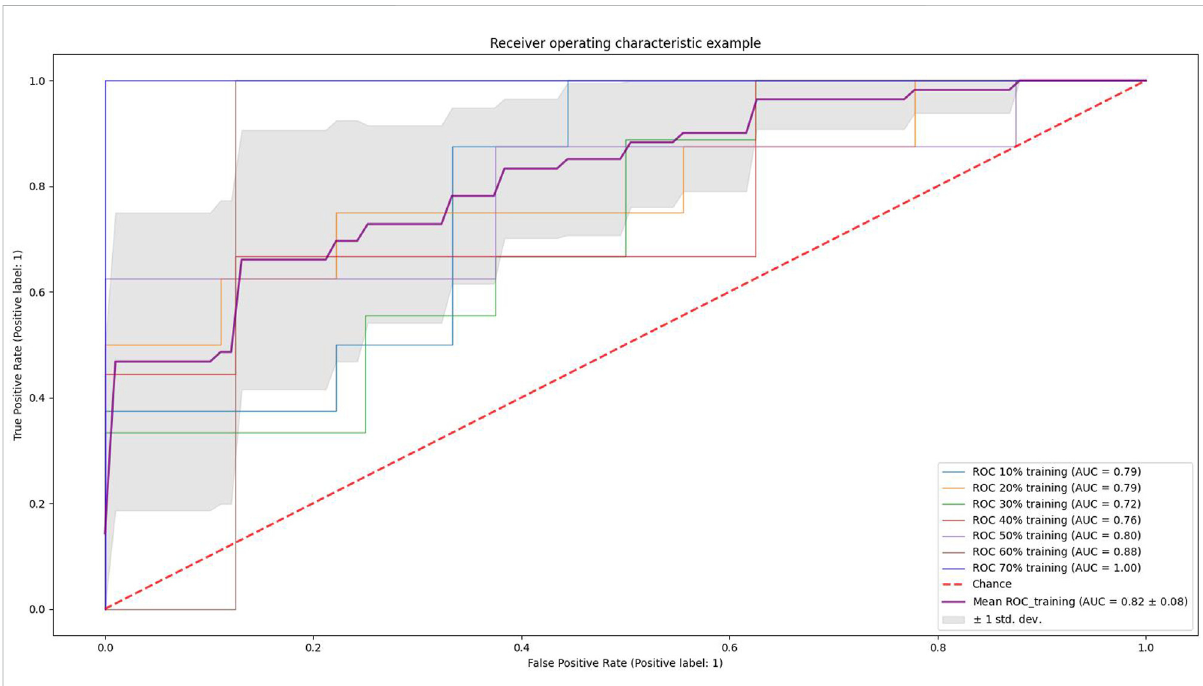
FIGURE 5 Example of receiver operating characteristics. The light blue curve in the fi gure indicates the results of the experiment when 10% of the dataset samples are used as the training set and 90% as the test set, light yellow indicates 20% of the dataset is used for training and 80% for testing, light green indicates 30% of the dataset is used for training and 70% for testing, light red indicates 40% for training and 60% for testing, light purple indicates 50% as the training set and 50% as the testing set, brown indicates 60% as the training set and 40% as the testing set, and dark blue indicates 70% of the data as the training set and 30% as the testing set. The curve highlighted in dark purple indicates the average value, and the gray area indicates the value space of the seven